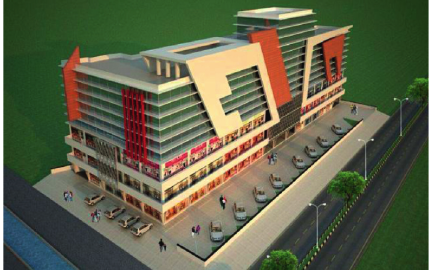
Figure 4: Architectural 3D view of eight-story